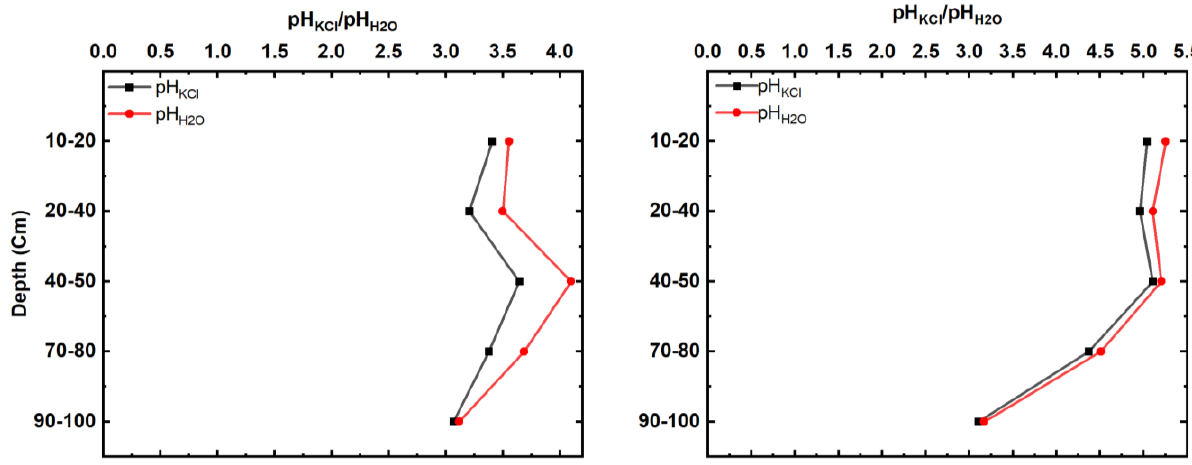
Figure 4. pH and pH profiles constructed from measurements on peat collected from depths of 10–20, KCl H2O